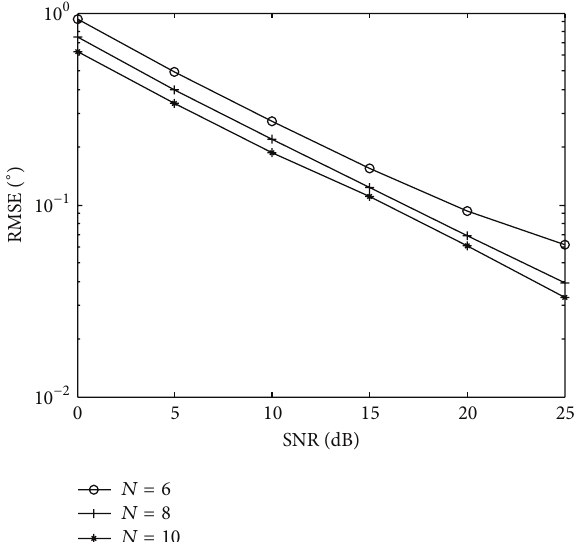
Figure 9: DOA tracking with different values of 𝑁 .